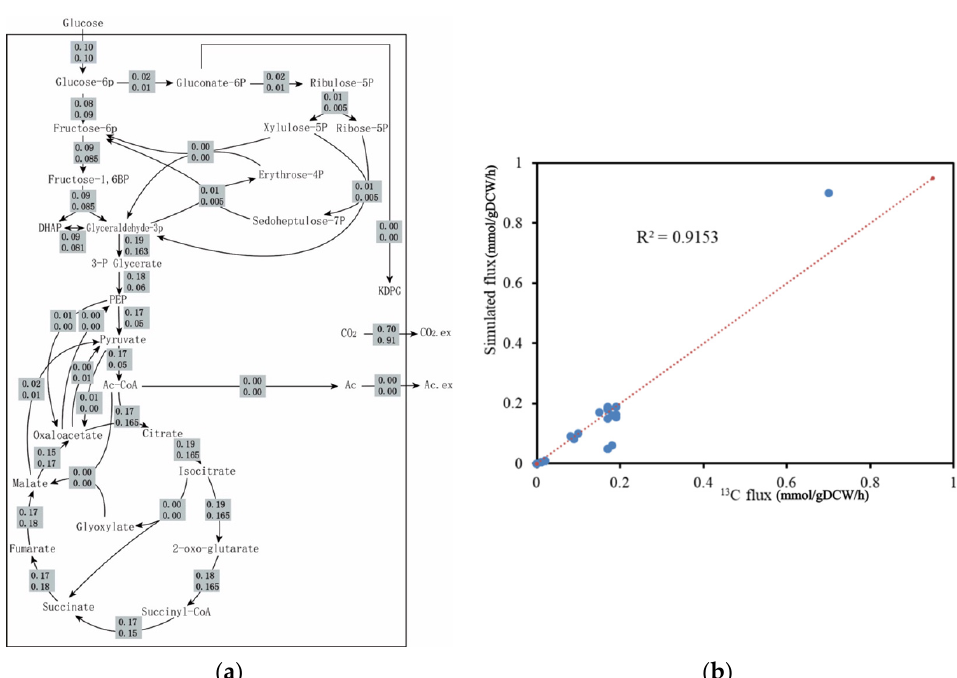
Figure 2. The distribution of the intracellular central metabolism flux (mmol/gDCW/h). ( a ) Metabolic flux profiles of the central metabolism of S. erythraea . The upper number represents the flux acquired from the 13 C metabolic flux analysis, and the lower number represents the flux simulated from our model iJL1426; ( b ) consistent changes in fluxes can be found in both the calculated 13 C fluxes and the FBA calculation using iJL1426.